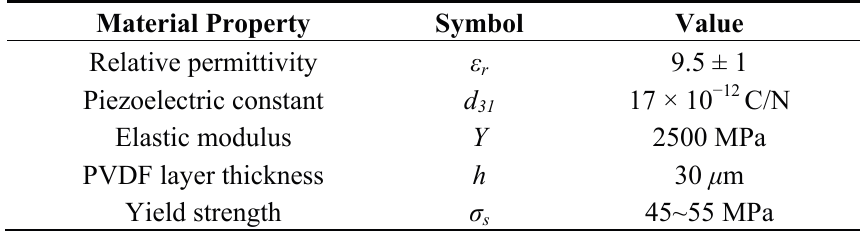
Table 2. Properties of the PVDF